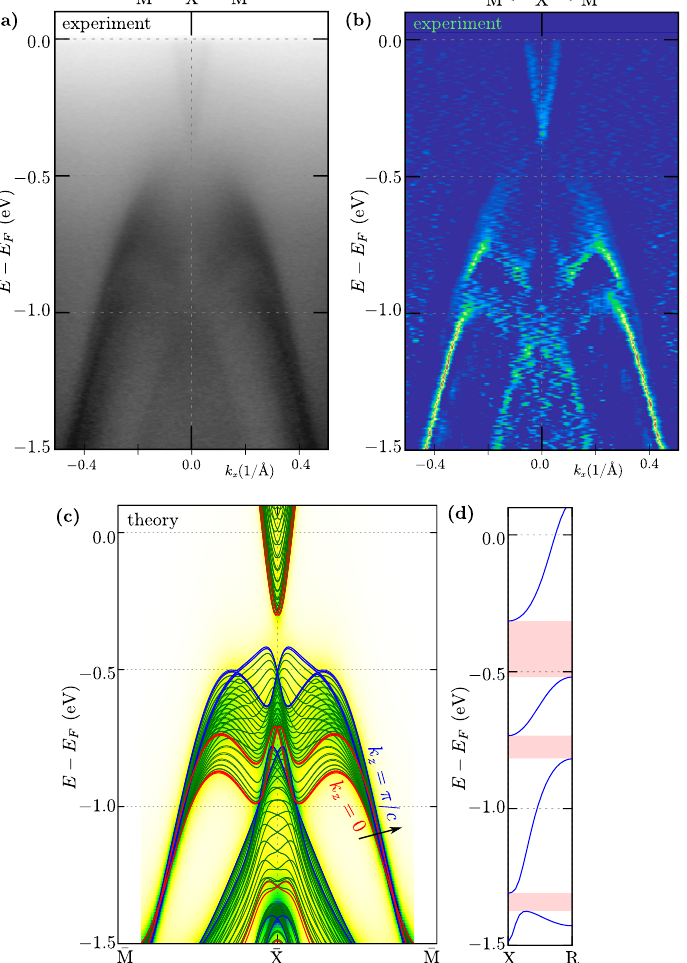
Figure 3. Comparison of the ARPES spectra ( a ) and corresponding 2D curvature ( b ) with the theoretical calculation: spectral function (background) and projected bulk bands (lines) ( c ). The results are presented along the ¯ X– ¯ M direction, around the ¯ X point. The experimental data have been collected with photon energy h ν = 66 eV at a temperature of 12 K. Panel ( d ) presents the energy range of the nodal lines in the bulk band structure along the X–R path (red areas mark the band gap between the nodal